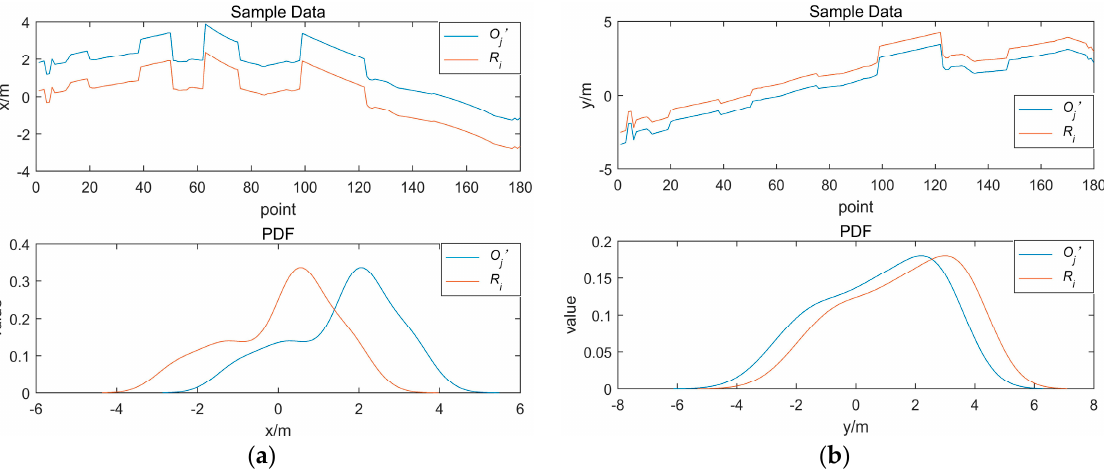
Figure 10. Sample data distribution and probability density function of data sets 𝑂 𝑗’ and 𝑅 (cid:3036) : ( a ) x-axis; ( b ) y-axis.